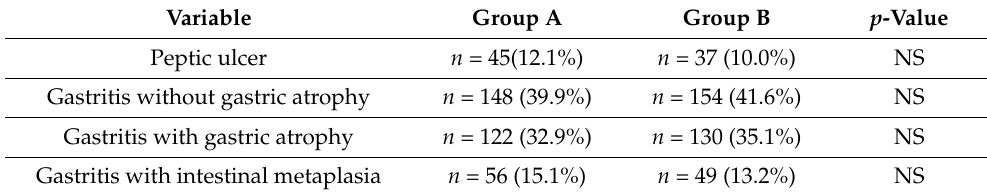
Table 2. Endoscopic findings of the study